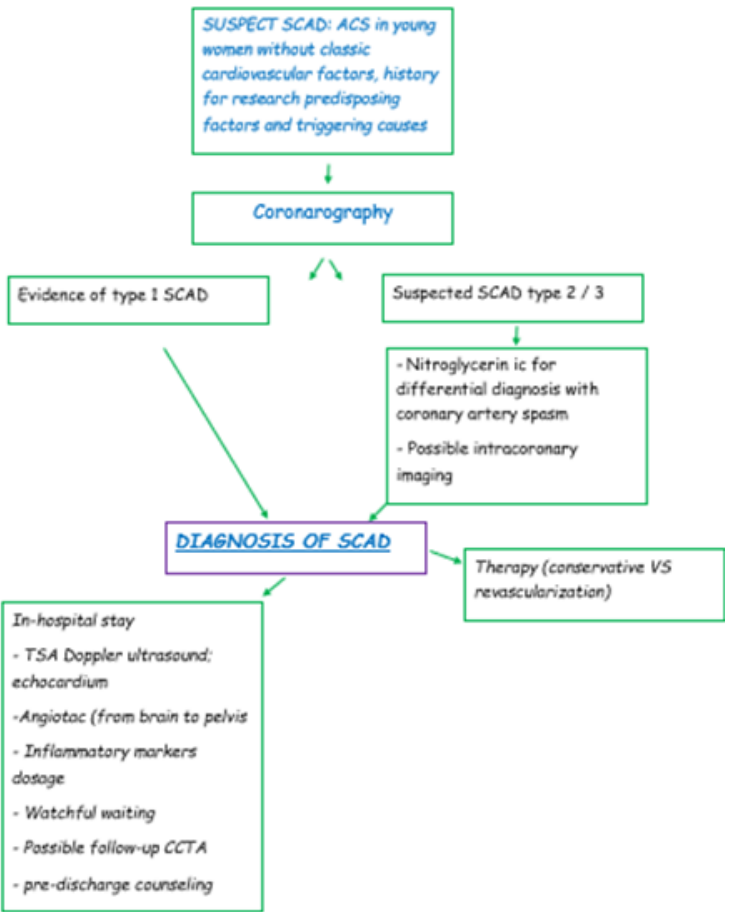
Figure 6. Diagnostic algorithm of a suspected SCAD. SCAD: spontaneous coronary artery dissection; ACS: acute coronary syndrome; IC: intracoronary; TSA: supra-aortic trunk; CCTA: cardiac coronary tomography angiography.